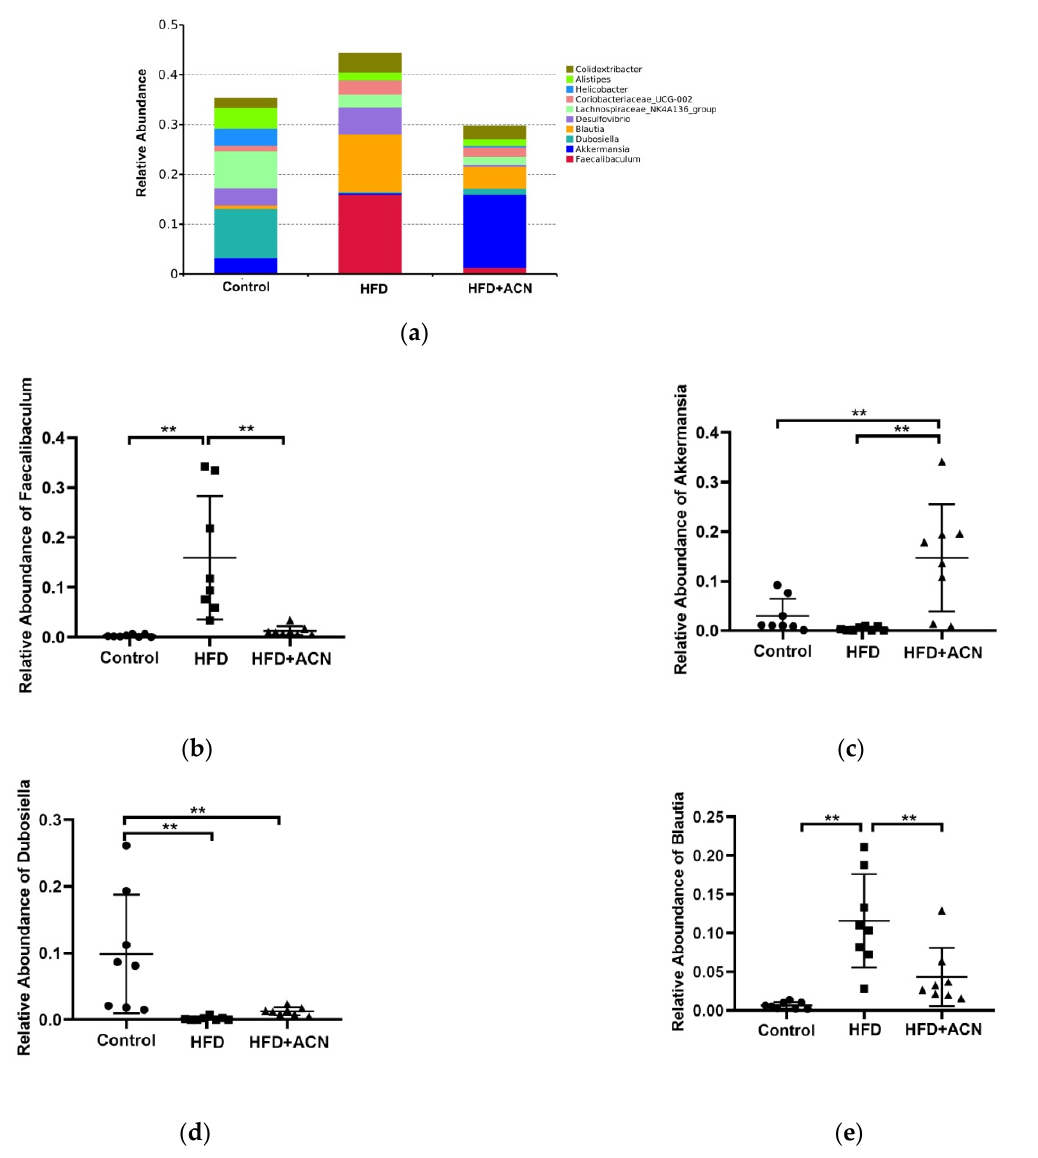
Figure 4. The changes in the gut microbiota structure at the phylum level. Data are expressed as the mean ± SD (n = 8 for each group), ** denotes p < 0.01. ( a ) PCoA plot. ( b ) Histogram of the relative abundance of the dominant bacterial phyla. ( c ) The relative abundance of Firmicutes . ( d ) The rela- tive abundance of Bacteroidota . ( e ) The ratio of Firmicutes to Bacteroidota . ( f ) The relative abundance of Verrucomicrobiota .